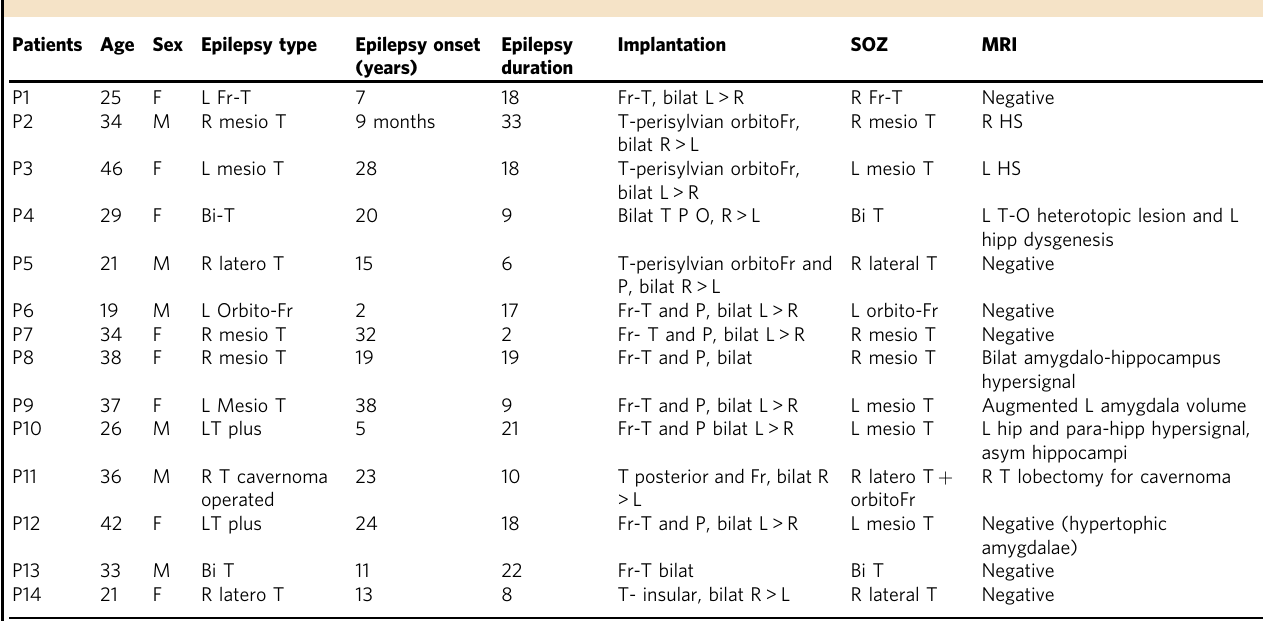
Table 2 Patient characteristics Patients Age Sex Epilepsy type Epilepsy onset